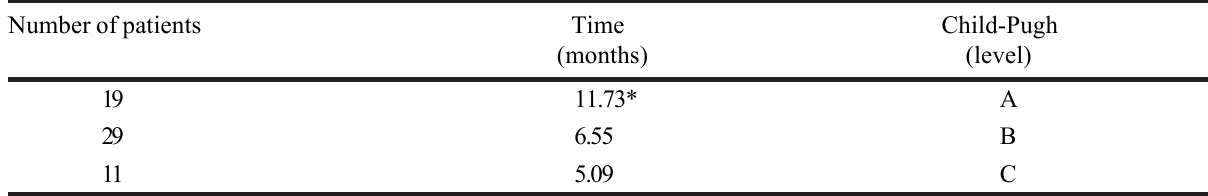
TABLE 3 - Correlation between the severity of the disease and the time elapsed since the patient was listed for liver